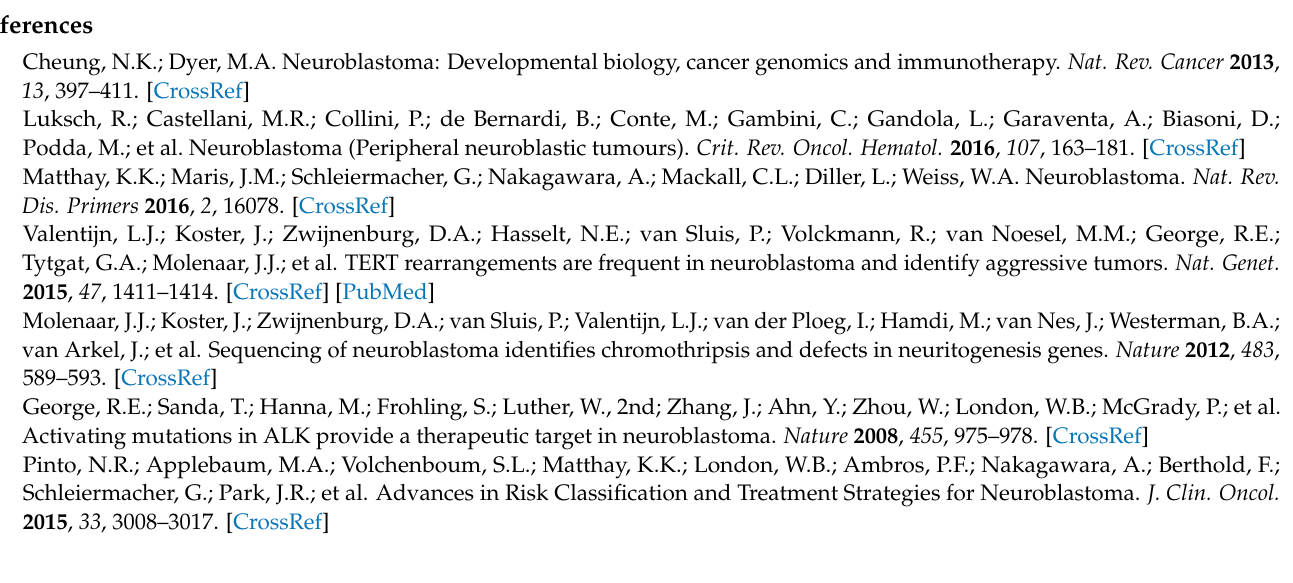
in NB. Figure S3: ISX effects on GLI3. Figure S4: ISX and primary cilia. Figure S5: Structure-activity relationship (SAR) of ISX. Figure S6: ISX and HAT activity. Figure S7: GLI1-dependency of ISX. Table S1: RLU values from epigenetic drug